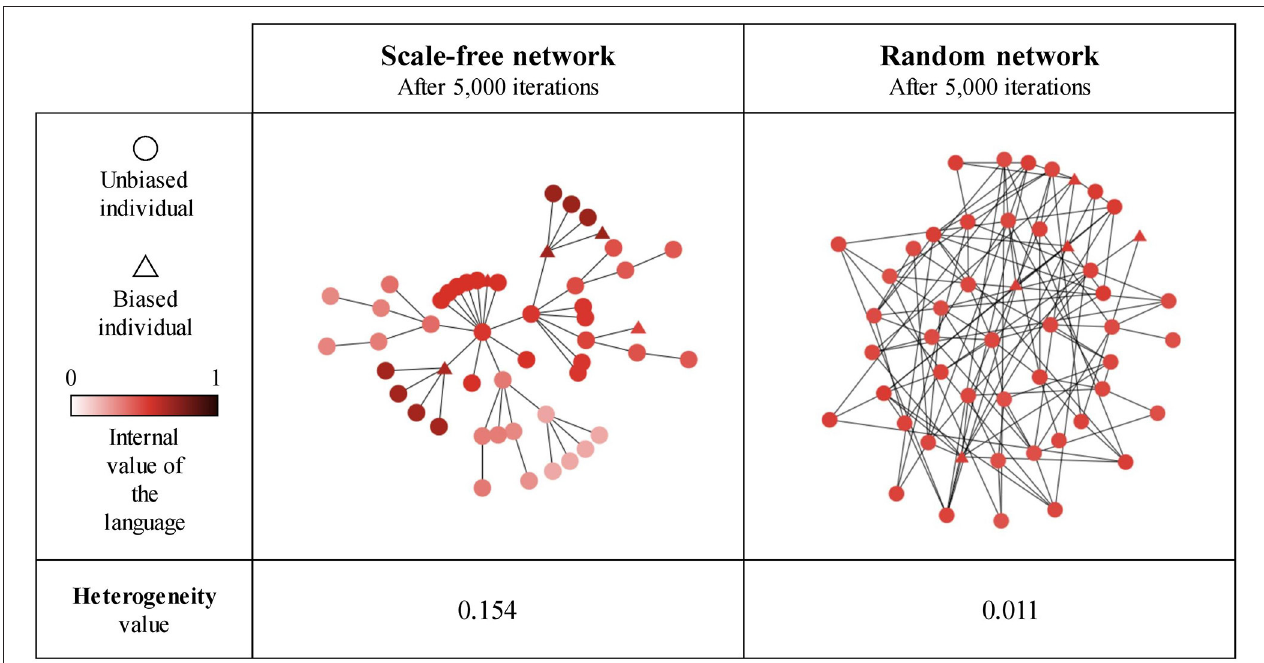
FIGURE 3 | The evolution of the agents’ internal representation of the language (node color) after 1 and 30 iterations in a scale-free network of n = 30 agents. In each iteration, all individuals speak and receive the utterance produced by all their neighbors. (Left) Initial state of the network before any interaction (i.e., reflecting the prior biases); (Middle) after 1 iteration; (Right) after 30 iterations.